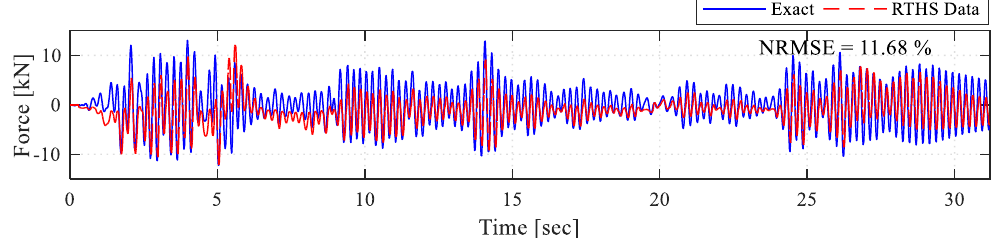
Figure 22. Brace obtained force feedback from Model 1a RTHS test with specimen as compared to the exact analytical solution.